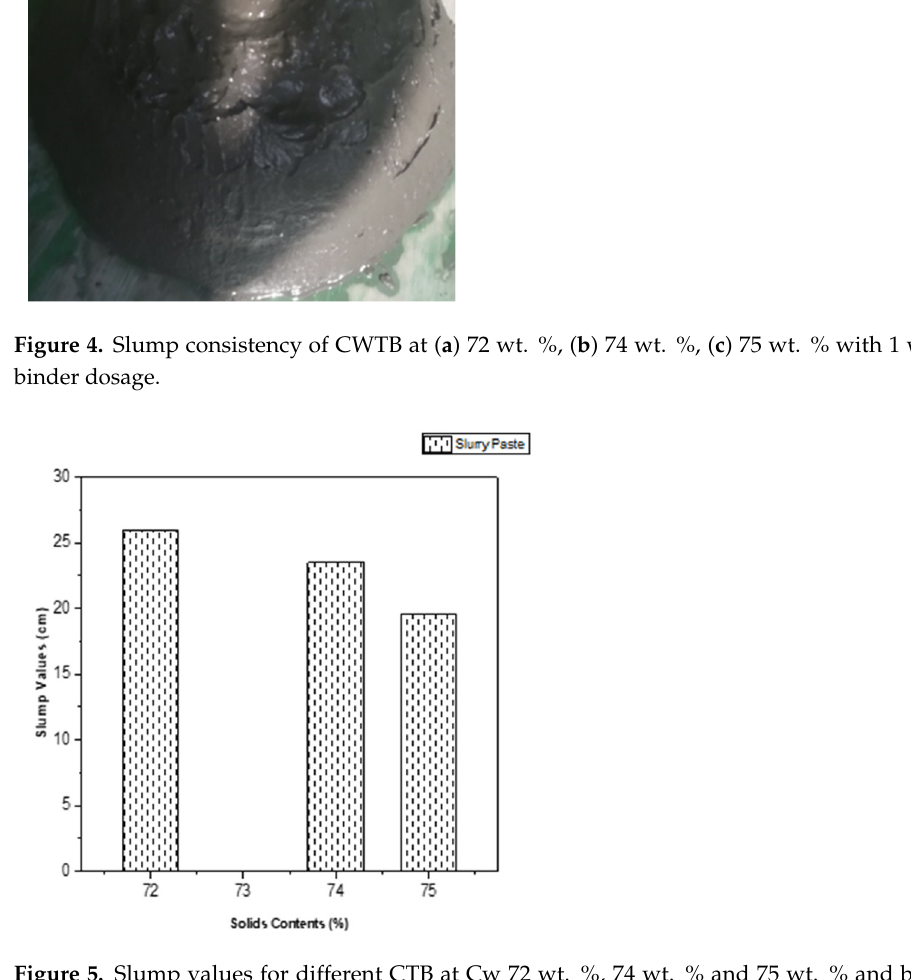
Figure 6. Relationship between yield stress and slump values for different CTB at Cw 72 wt. %, 74 wt. % and 75 wt. % and binder of 1 wt. %. 3.2. Effect of Solid Content on the Microstructural Properties of CWTB Figure 7 shows scanning electron microscope (SEM) images of different binder dos- ages 1, 3 and 5 wt. % at a solid content of 75 wt. %. The tailings had a rough and uneven surface, while the natural sand had a smoother surface [34] . Indeed, the percentage of ordinary Portland cement has increased in the formulation of paste backfill mixtures. There is an increase in the mechanical strength of CWTB samples due to the activation of secondary C-S-H gels such as ettringite, C 3 S gypsum contained in ordinary Portland ce- ment. Besides, adding Portland cement is very effective in reducing metal mobility. The hydration age of 14 days at 75 wt. % solids content with 5 wt. % binder dosage is presented in Figure 7a,b. From these figures, we have the confirmation of the increase in hydration products reveals by the X-ray diffraction test. The increased dose of OPC allows direct particle-to-particle contact, which improves the microstructure of CWTB samples and leads to CSH gel, ettringite and gypsum formation. So, the use of OPC binder leads to a reduced permeability of the paste at solids content of 75 wt. %. In Figure 7c,d, after the hydration age of 28 days at 75 wt. % solids content with 3 wt. % binder dosage, there are a glassy phase and some lower hydration products that bond to the cemented particles. We can observe the tailings, quartz and some lower presence of voids. However, Figure 7e,f shows that after hydration age of 42 days at 75 wt. % solids content with 1 wt. % of binder dosage, there is a high porosity (presence of voids) and insufficient quantity of hydration products to bond to the cemented. Note that X-ray